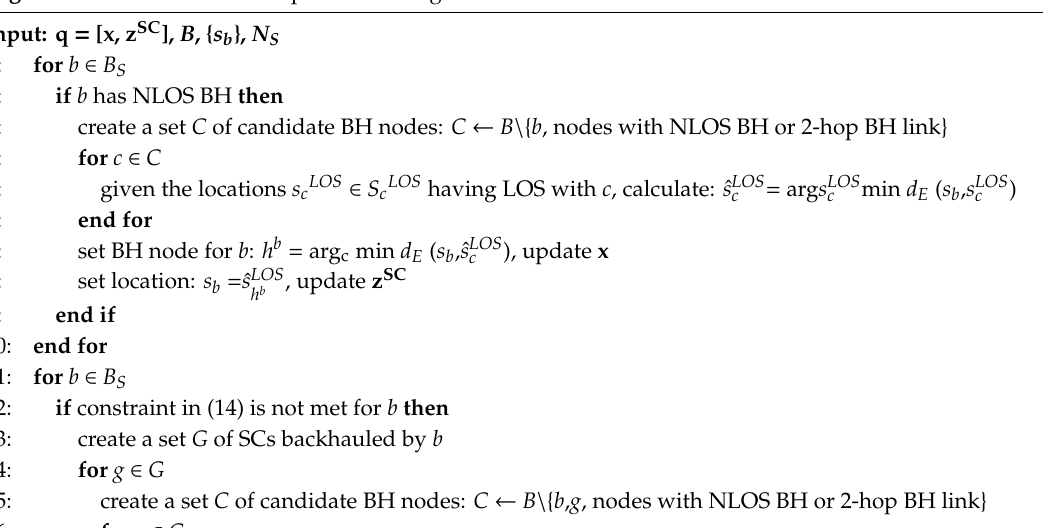
Algorithm 2 Backhaul-aware optimization